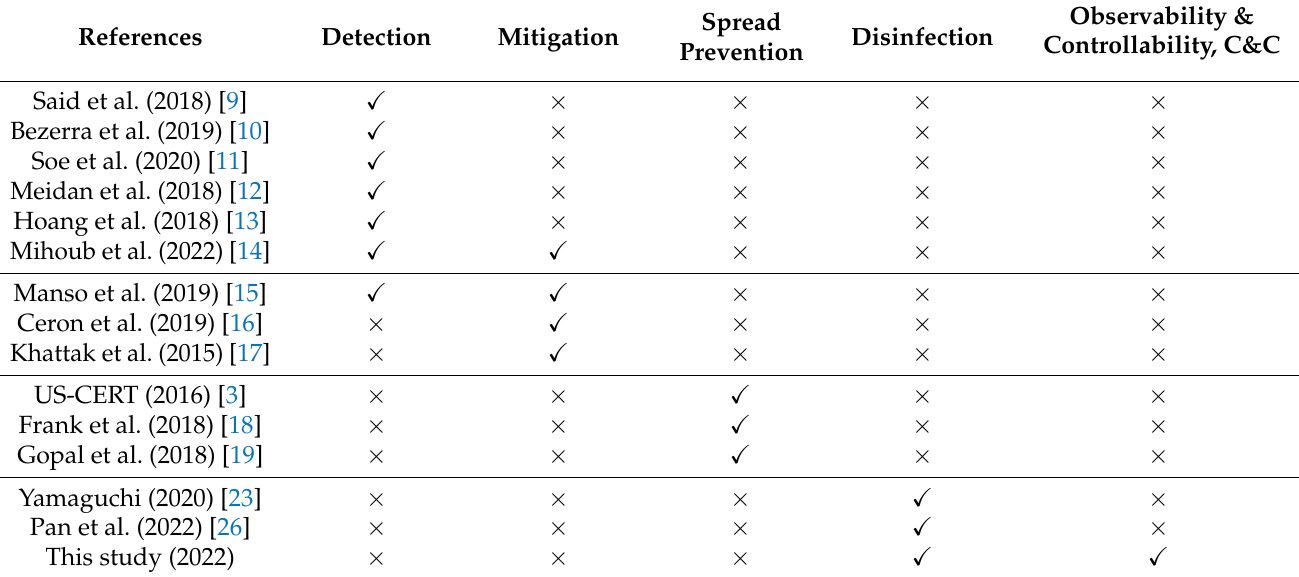
Table 4. Positioning of this study within the relevant